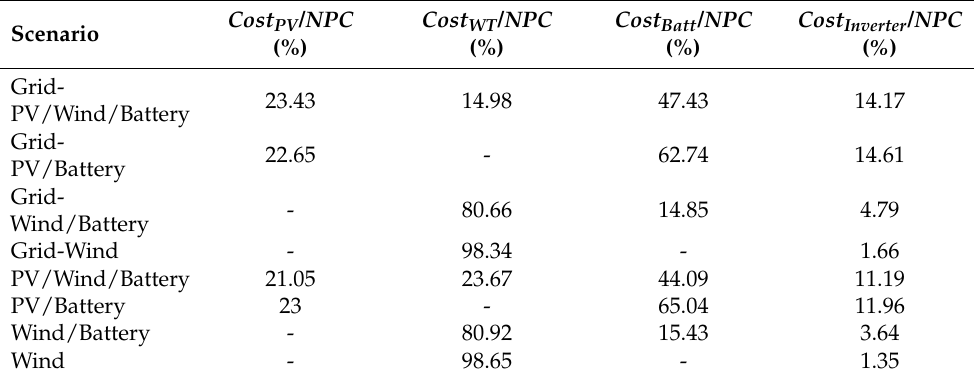
Table 10. Distribution of the net present cost between the components of the